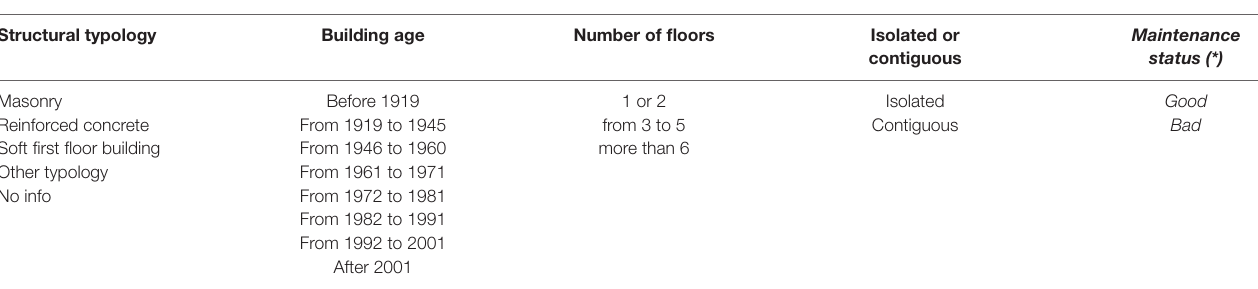
FIGURE 3 | (A) Seismic scenario of the December 26, 2018 earthquake. Dotted box represents the study area. (B) Detail of the same scenario applied at the urban scale of the census sections defined by ISTAT. TABLE 1 | Typological parameters of the buildings, according to ISTAT census